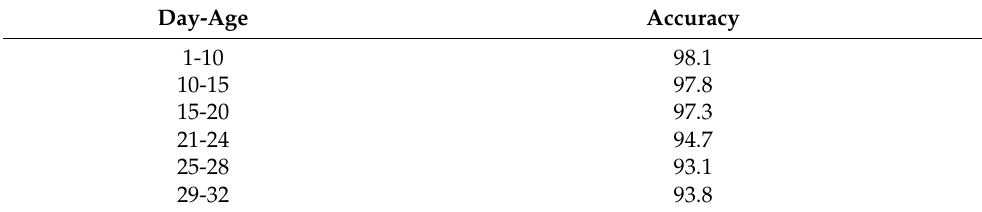
Table 4. Experiment results on different day-age of ResNet50.